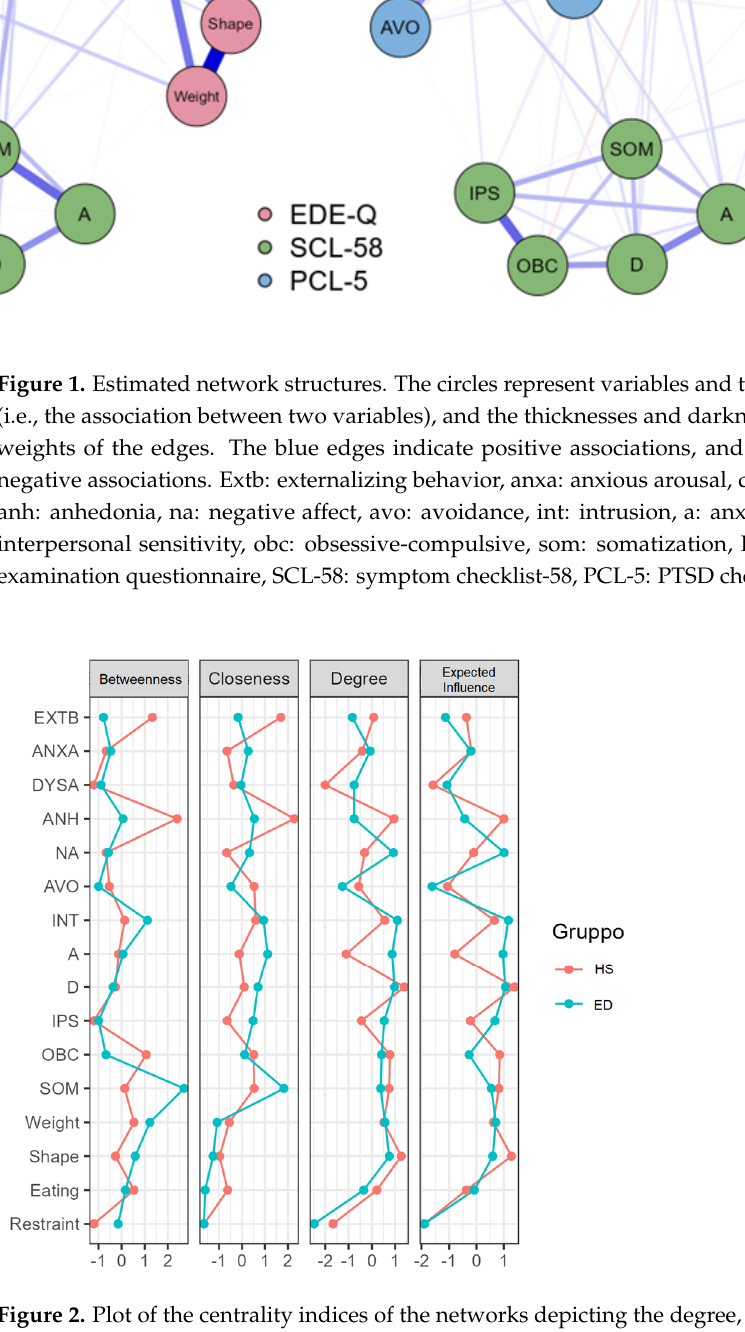
Figure 3. Plot of the clustering indices of the networks. Extb: externalizing behavior, anxa: anxious arousal, dysa: dysphoric arousal, anh: anhedonia, na: negative affect, avo: avoidance, int: intrusion, a: anxiety, d: depression, ips: interpersonal sensitivity, obc: obsessive-compulsive, som: somatization. The centrality stability coefficient strength of the network of the ED patients was 0.34, while that of the HS group was 0.30, and both are considered acceptable. The groups displayed similar values for the maximum difference in all the edge weights of the